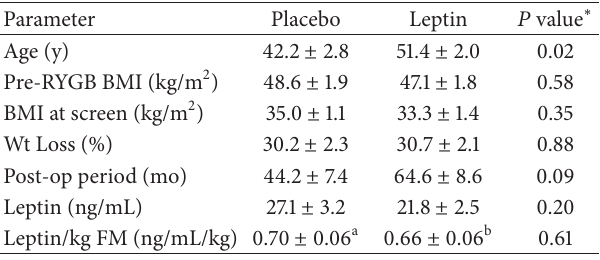
Table 1: Baseline characteristics of study